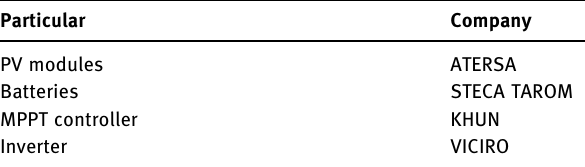
Table 1: PV system components